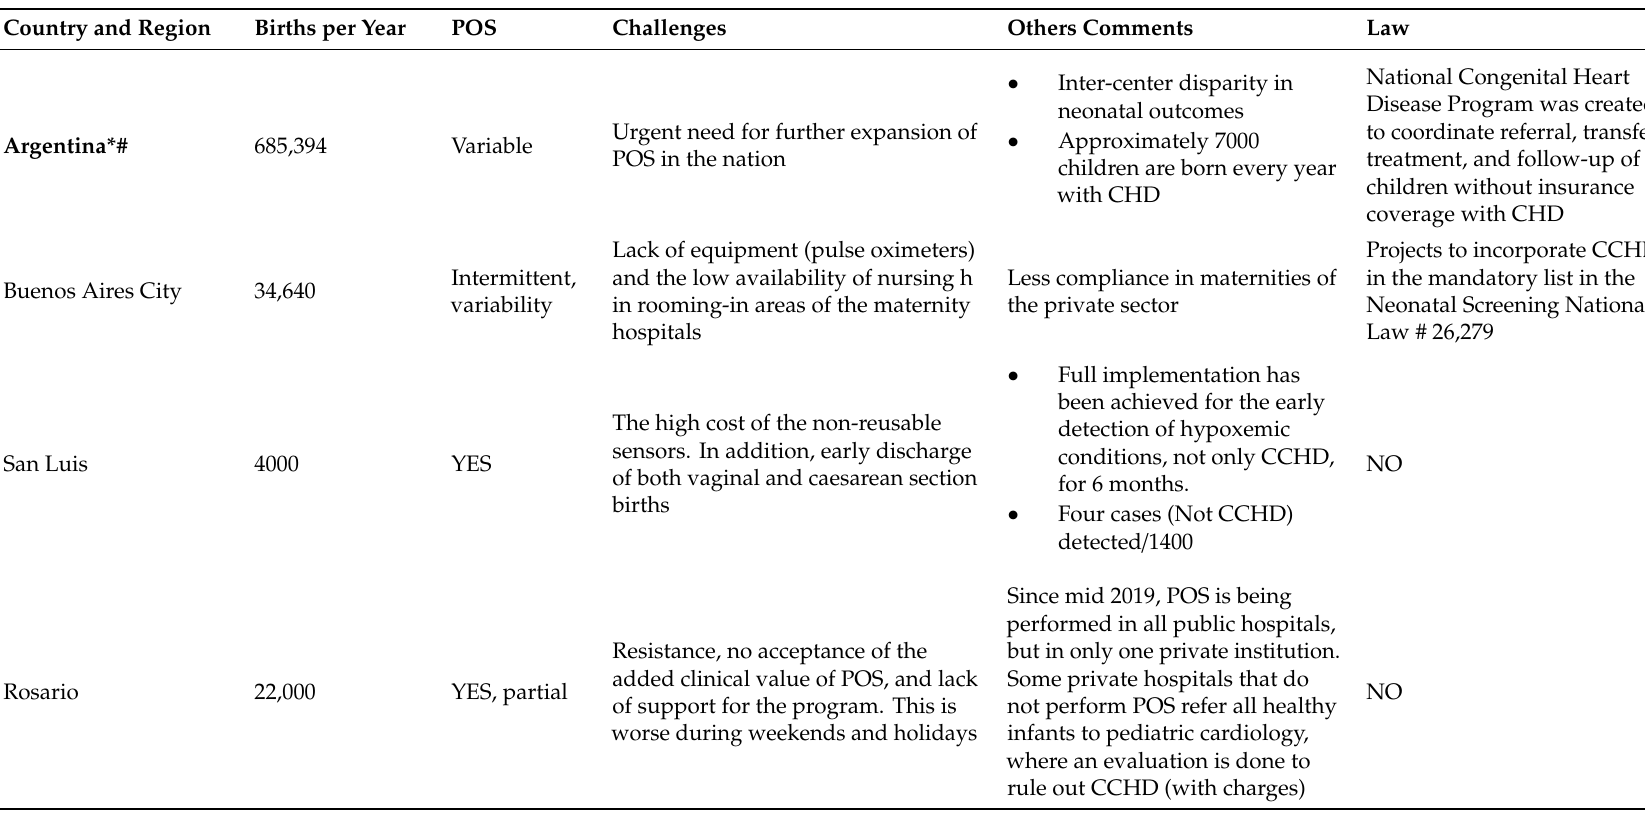
Table 2. POS implementation e ff orts in some Latin American countries: Summary of